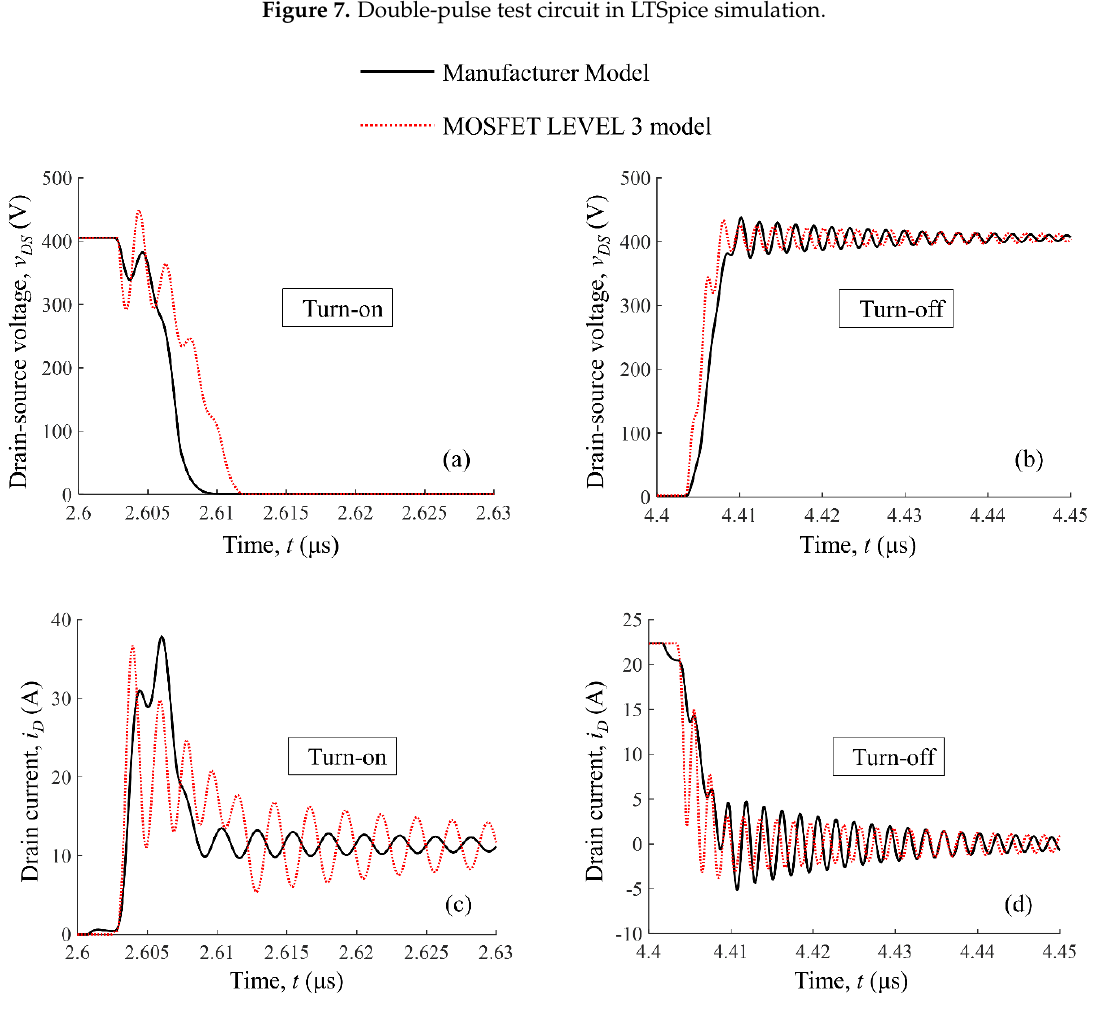
Figure 8. Simulated switching waveform obtained with the MOSFET LEVEL 3 model in comparison to the manufacturer model; ( a , c ) are showing drain-to-source voltage and drain current waveforms for the turn-on interval, whereas ( b , d ) are showing drain-to-source voltage and drain current waveforms for the turn-off interval.